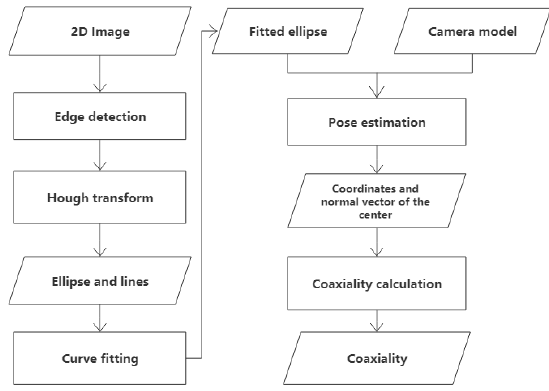
Figure 2. Flowchart of coaxiality